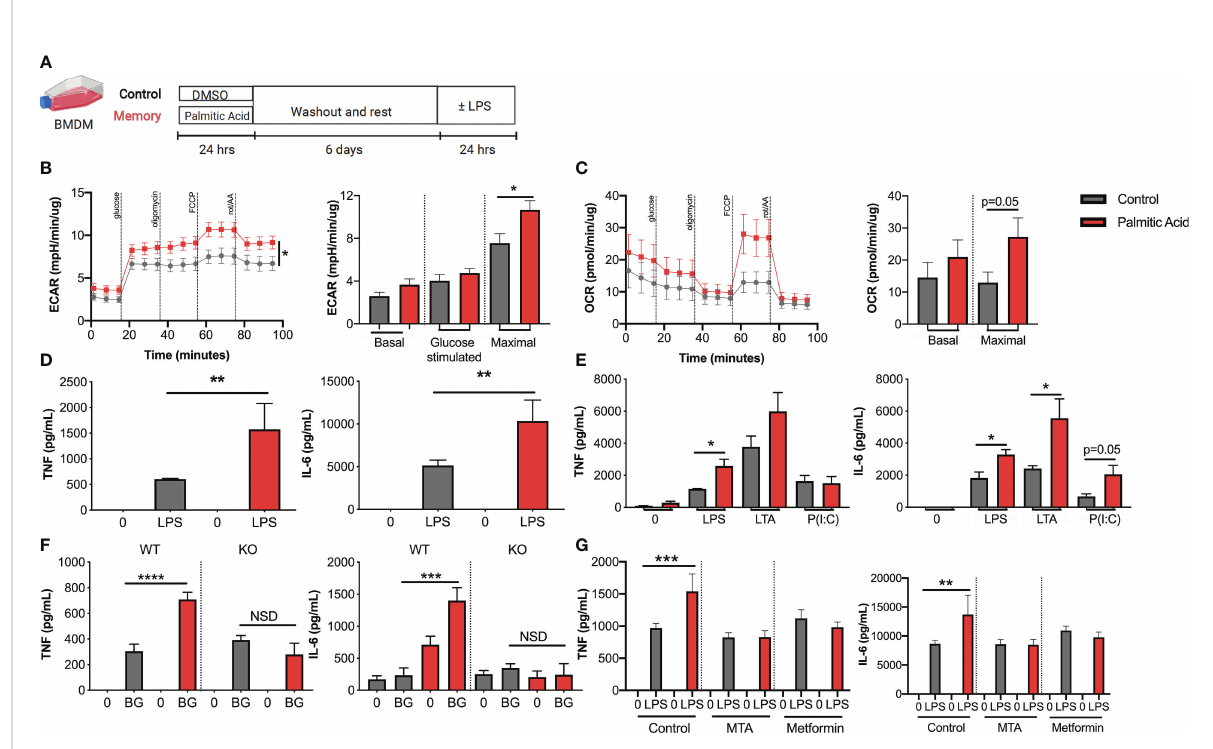
FIGURE 2 Palmitic acid increases maximal cell metabolism and in fl ammation in macrophages in culture. (A) Schematic of innate immune memory in vitro models using bone marrow derived macrophages and 0.4 mM palmitic acid or control (DMSO). (B) Extracellular acidi fi cation rate (ECAR) and (C) oxygen consumption rate (OCR) during modi fi ed mitochondrial stress test by Seahorse metabolic analyzer after 6-day washout (D) 100 ng/mL LPS- induced TNF and IL-6 production by ELISA and normalized by protein concentration. (E) 100 ng/mL LPS-, 1 m g/mL LTA- or 1 m g/mL P(I:C)- induced TNF and IL-6 production by ELISA and normalized by protein concentration. (F) 100 ng/mL LPS-induced TNF and IL-6 production by ELISA in WT or TLR4-KO mice and normalized by protein concentration. (G) 0.5 mM 5 ’ -methylthioadenosine (MTA) or 10 m M metformin were added during the initial 24-hour treatment with palmitic acid. TNF and IL-6 production was measured by ELISA after 100 ng/mL LPS activation. Data are means ± SEM of 3-7 populations, representative of 2-3 independent experiments. * p < 0.05, ** p < 0.01, *** p < 0.001, **** p <.0001, NSD= no signi fi cant